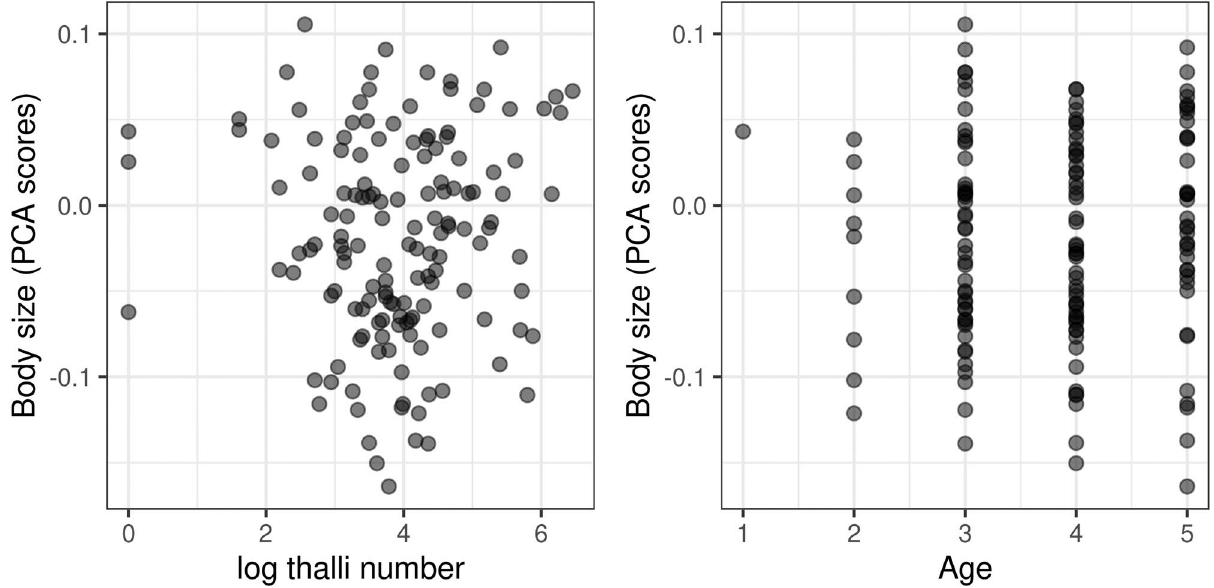
Figure 2. Visualization of how log-transformed thalli number (left panel) and age (right panel) are associated with body size; based on our LMM neither of them had significant effect on the workers’ size.